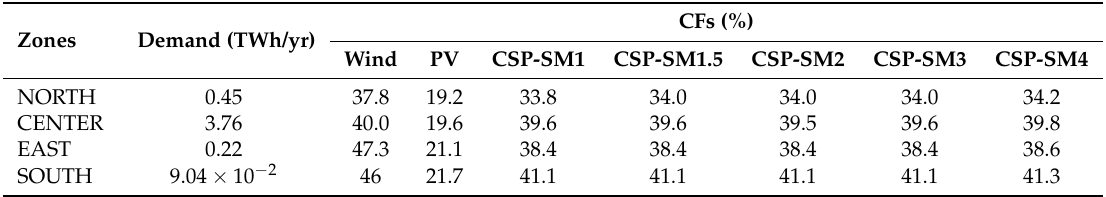
Table 2. Predicted yearly demand for 2018 (fitted) and CFs averaged over the same year (after bias correction) per zone and